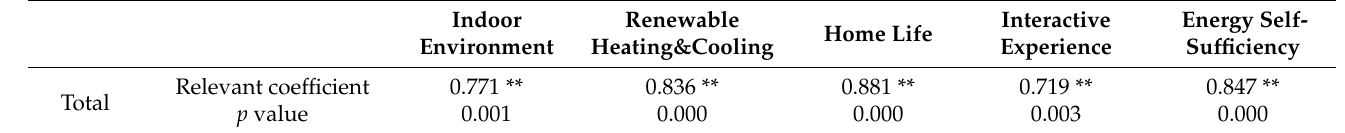
Table 9. Correlation analysis of the score of five subjective items with the total score in SDC2021. Engineering& Market Communications Energy Contest Architecture Construction Potential Contest Scores Scores Contest Scores Contest Score Contest Scores Relevant coefficient 0.838 ** Total